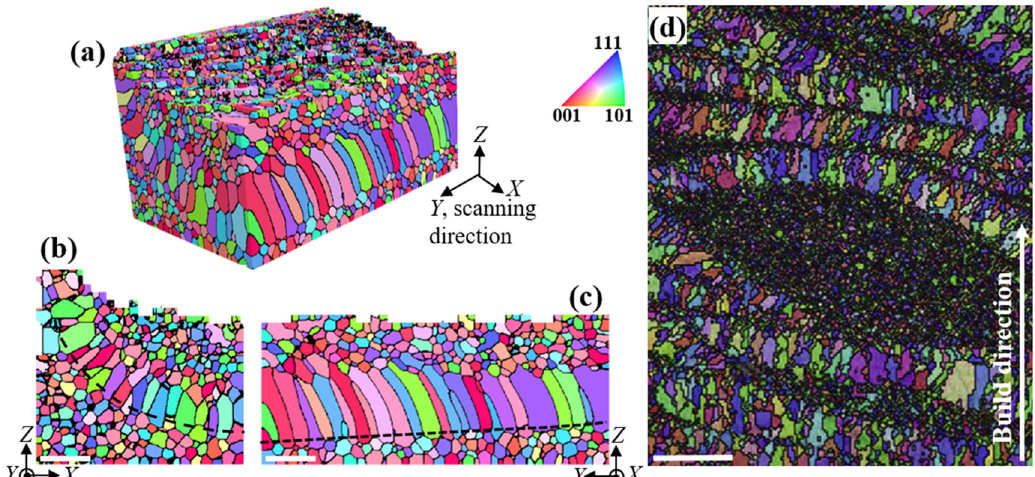
Fig. 9 Grain morphology of SLMed 316 L stainless steel re fi ned by TiB 2 nanoparticles. a – c Simulation results; d EBSD mapping adopted from the work of AlMangour et al. 29 . The black dashed lines in b and c indicate the molten pool boundary. The PF simulation domain is 175 × 105 × 100 μ m 3 . Figures d is reprinted from ref. 29 with permission from Elsevier. Scale bars, 25 µm in b , c and 50 µm in d